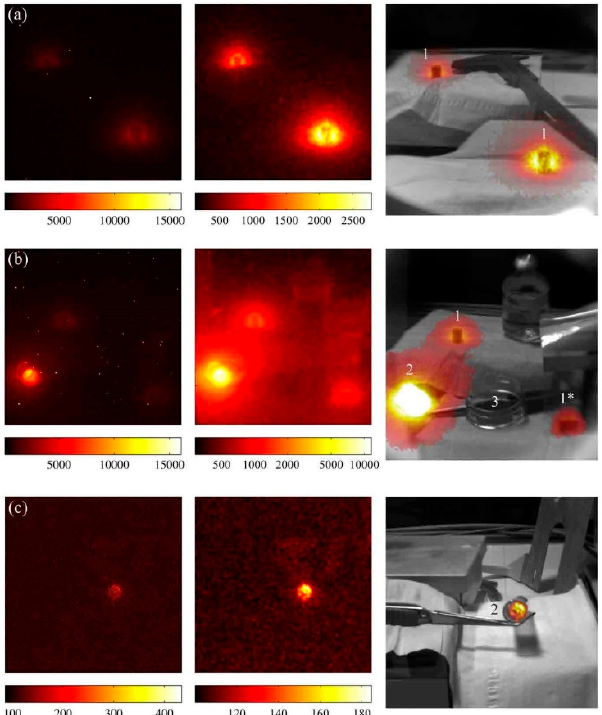
Figure 4. ( a – c ) The results of imaging α under three different conditions. The imaging is performed by superimposing the imaging of α in dark conditions on the imaging of the physical object in light conditions. The image on the left shows α imaging in the dark, while the image on the right shows the final image after superimposing the physical image in the light [58]. This figure is reprinted with the permission of Elsevier.